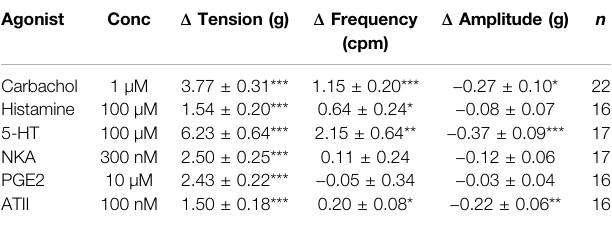
TABLE 1 | Summary of U&LP tissue spontaneous phasic activity. Tension, frequency, and amplitude recorded in response to receptor agonists. Data presented as mean ±